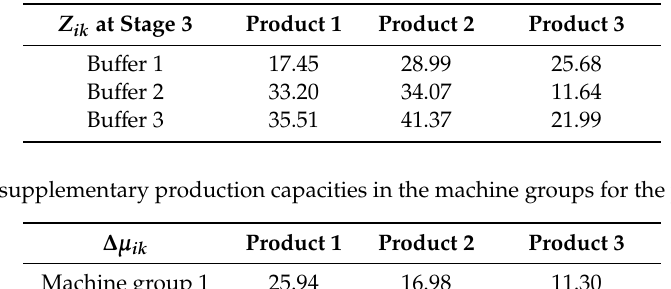
Table 6. The hedging points of the product types in the bu ff ers at stage 3.